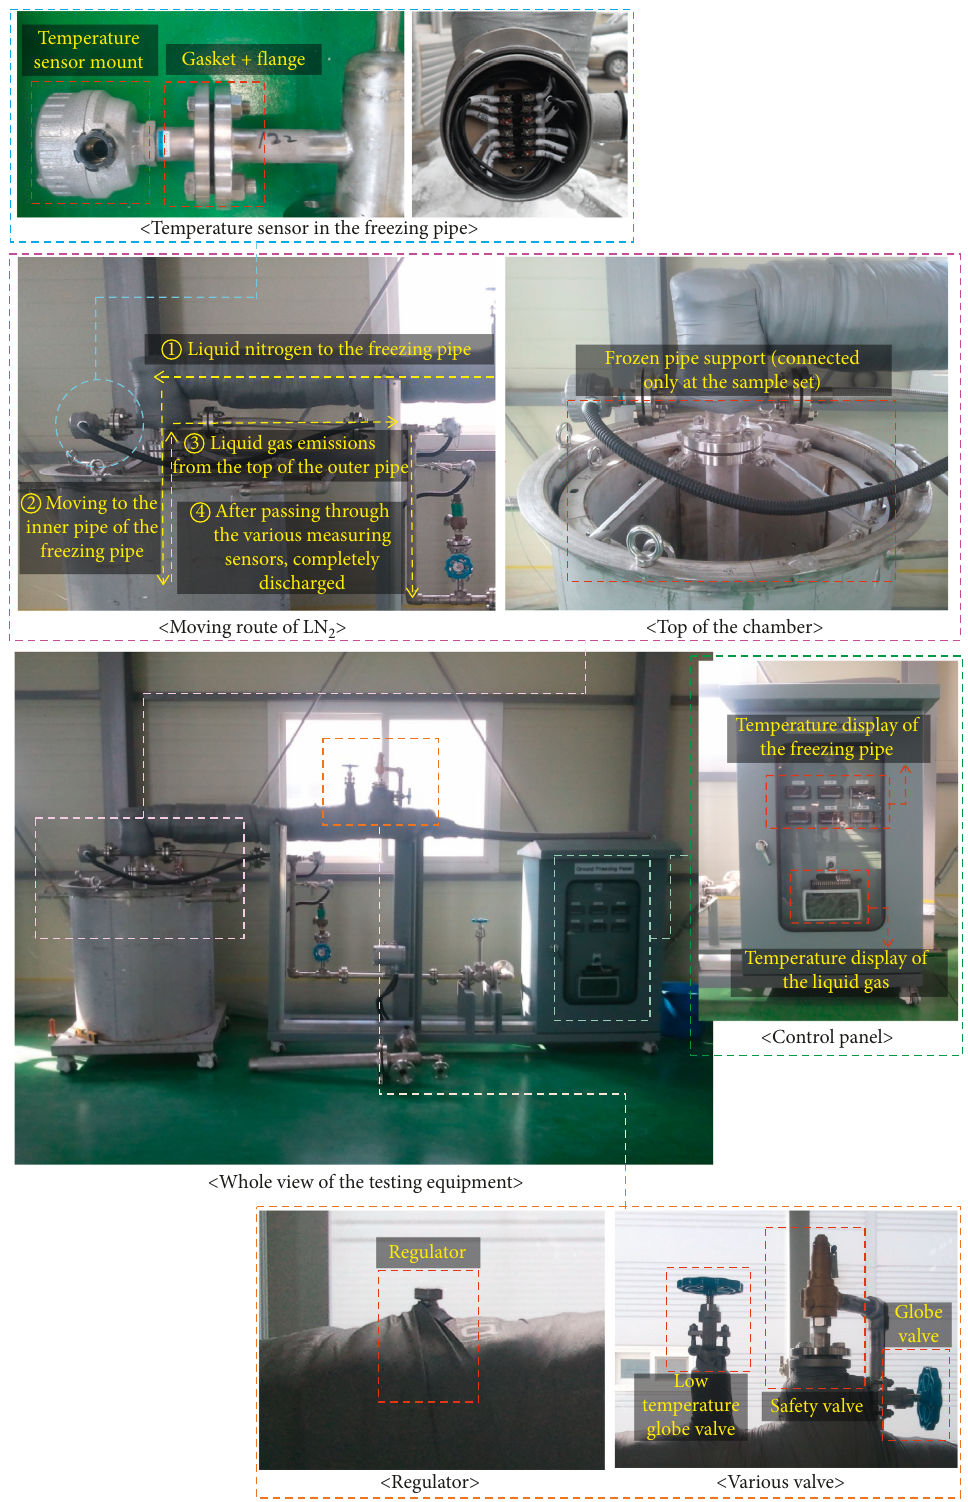
Figure 1: Developed ground freezing